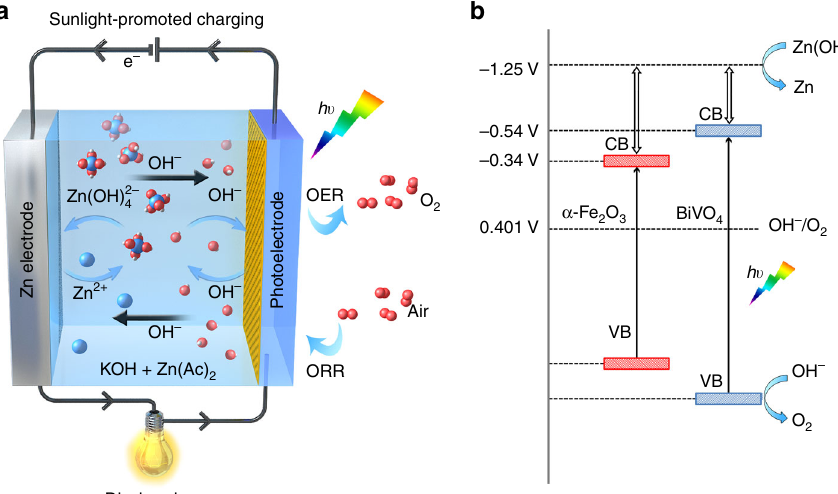
Fig. 1 Schematic sunlight-promoted charge and discharge processes of the sunlight-promoted zinc – air battery. a The scheme of the basic structure and working principle of the sunlight-promoted rechargeable zinc – air battery. b The proposed mechanism of the sunlight-promoted charging process under solar light